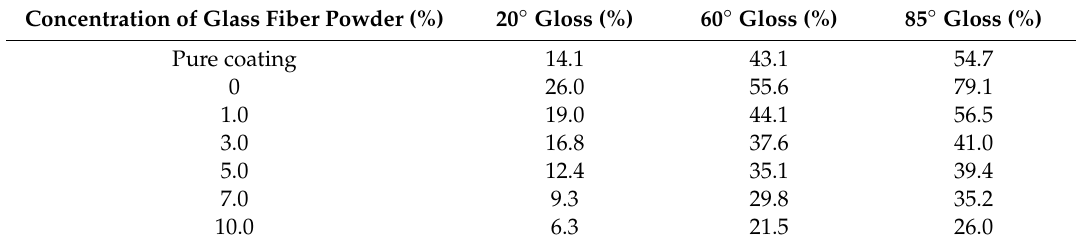
Table 3. Effect of glass fiber powder concentration on the gloss of waterborne coatings with thermochromic ink. Concentration of Glass Fiber Powder (%)